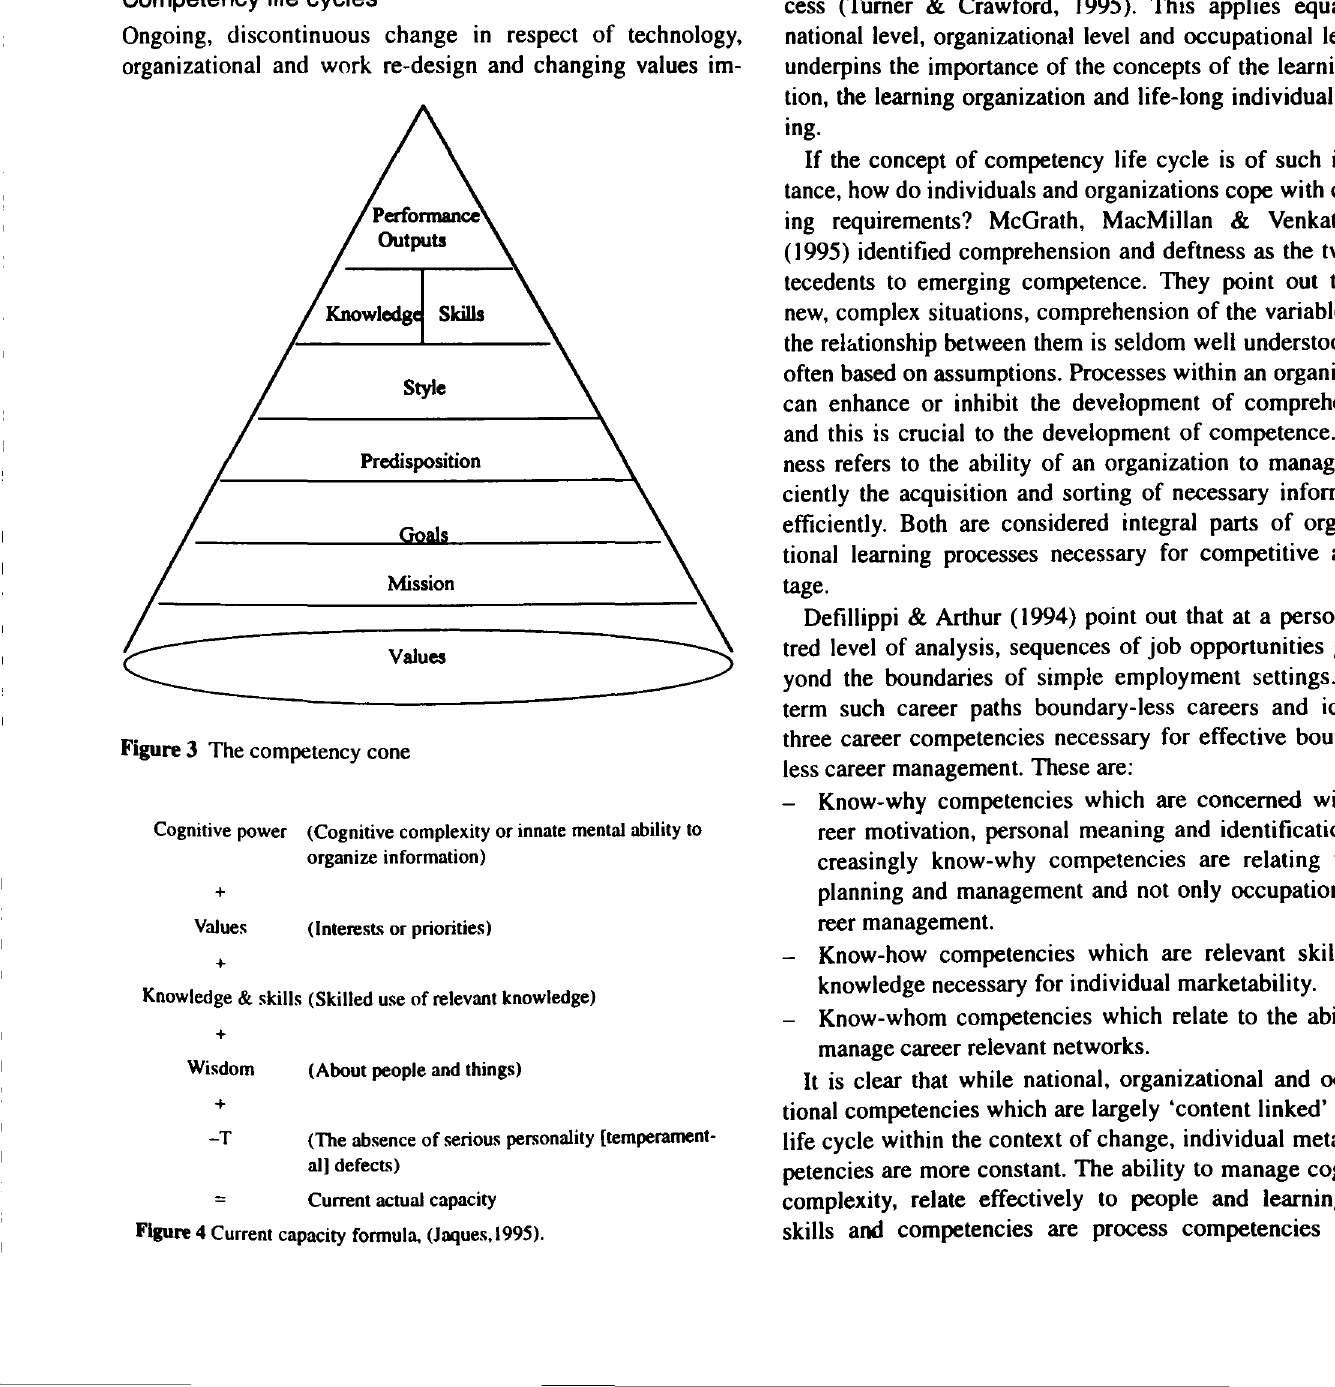
Cognitive power (Cognitive complexity or innate mental ability to